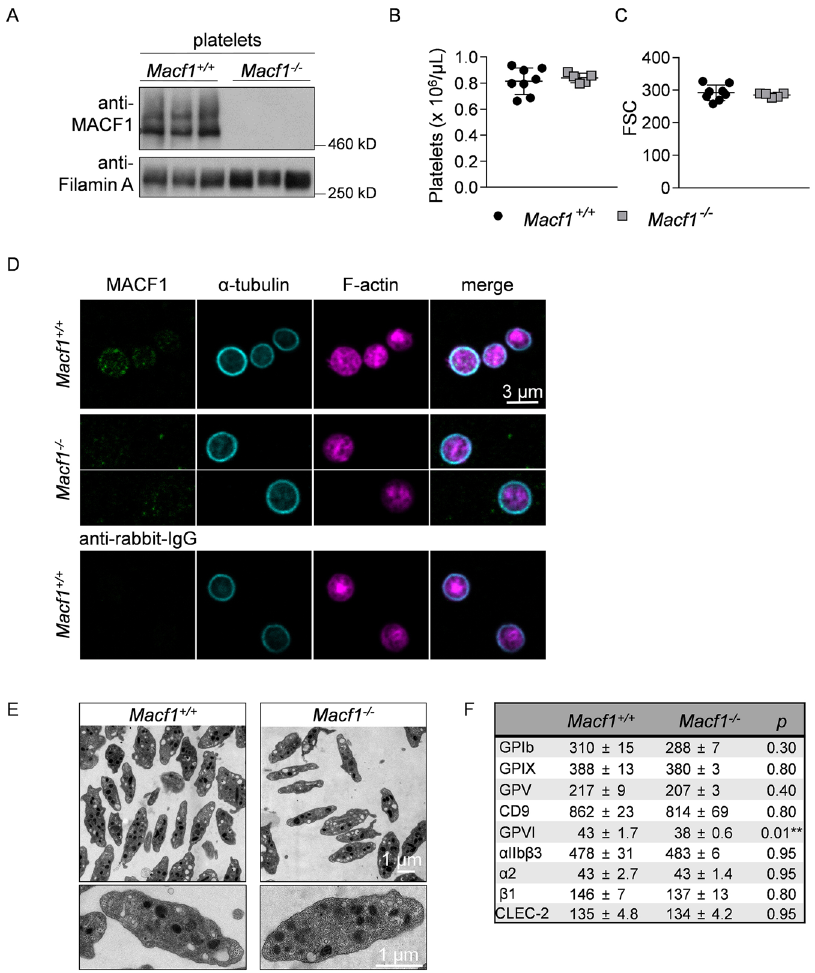
Figure 1. MACF1 deficiency has no effect on platelet count and size. ( A ) Western blot analysis of MACF1 expression in platelets. Loading control: Filamin A. (B) Platelet count per μ L and (C) platelet size given as mean forward scatter (FSC) were determined via flow cytometry. (D) Immunostaining of resting platelets on Poly-L- lysine. Green: MACF1/ACF7, cyan: α -tubulin, purple: F-actin. Scale bar: 3 µ m. (E) Representative transmission electron micrographs (TEM) from Macf1 + / + and Macf1 − / − platelets. (F) Determination of glycoprotein expression by flow cytometry. Diluted whole blood was incubated with FITC-labelled antibodies and measured as mean fluorescence intensity (MFI); (n = 3); ** P < 0.01. (A,D,E) Representative of at least 3 versus 3